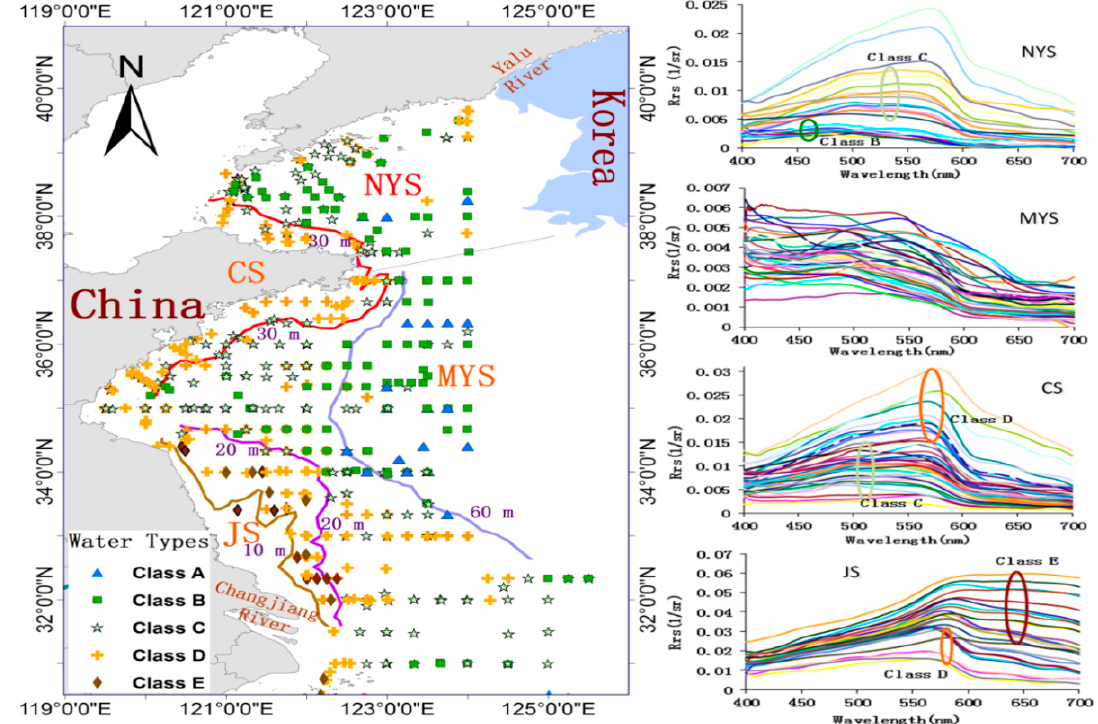
Figure 6. In-situ remote sensing reflectance ( R rs ) spectra classification for distributed features, with 10 m, 20 m, 30 m and 60 m isobaths. Four regions with typical bio-optical properties are shown; these regions include: coastal Shandong (CS, inner 30 m isobaths, north of 35°N), the north Yellow Sea (NYS, north of 37°N, where the part containing CS is excluded), the middle of the Yellow Sea (MYS, above 60 m isobaths), and Jiangsu shoal (JS, inner 20 m isobaths).